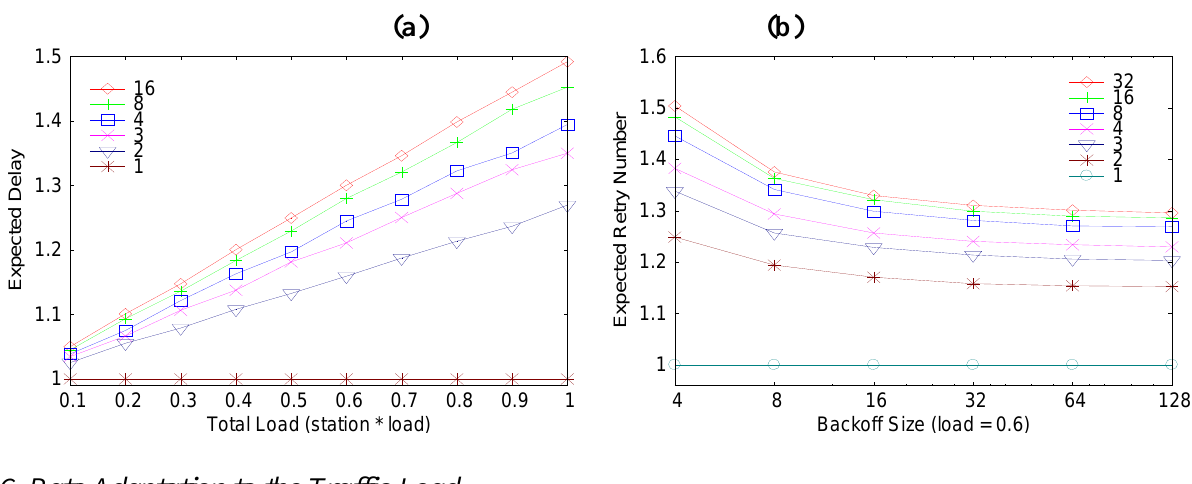
Figure 5. Expected delay and retry number as with load and backoff size. (a) expected delay from the child node to the parent node. (b) expected retry number of data sending from when the traffic load is